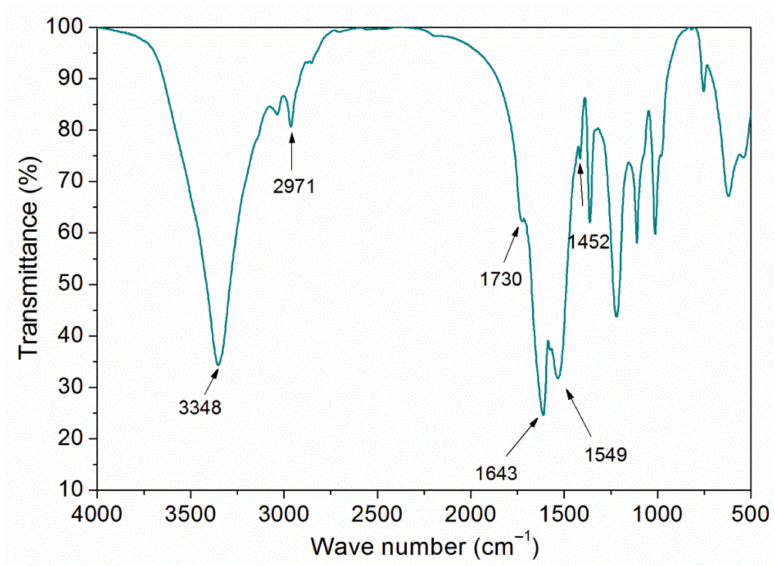
Figure 3. FT-IR of Nippon water-based emulsion